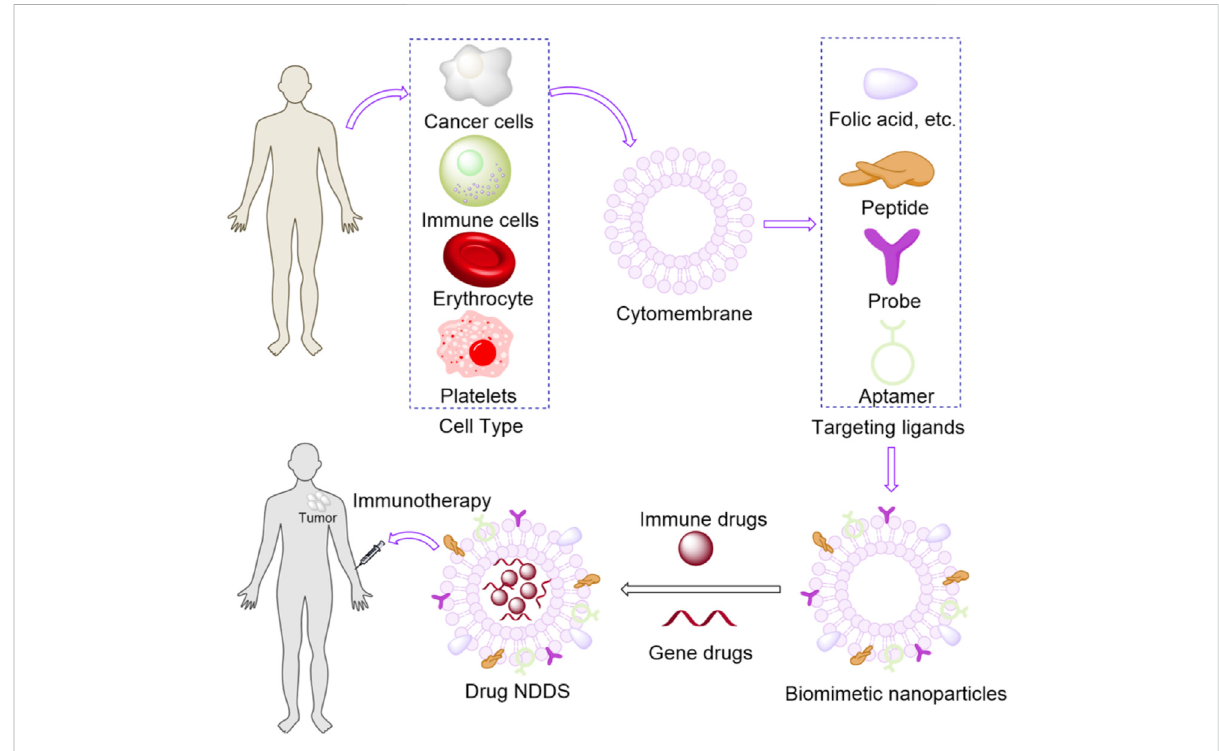
FIGURE 1 Biomimetic nanoparticles for tumor